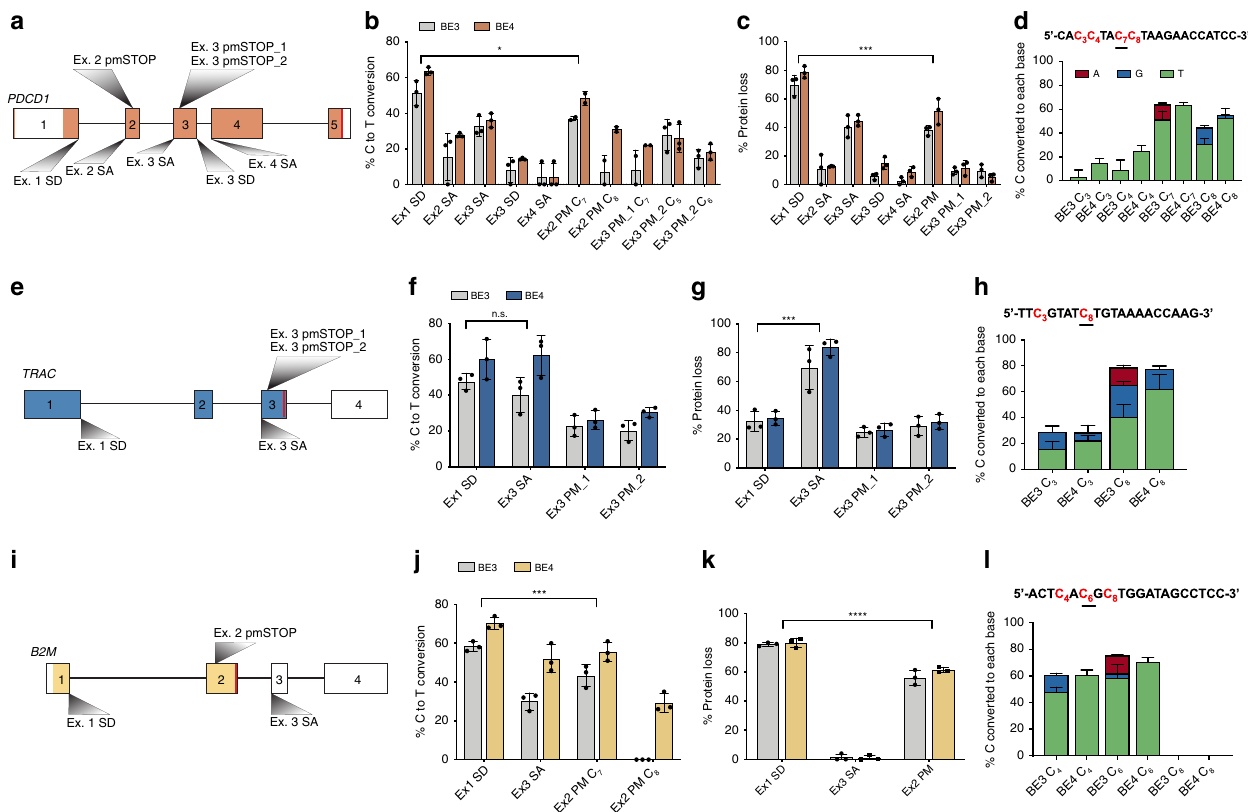
Fig. 1 Assessment of guide RNA activity for gene disruption at PDCD1 , TRAC, and B2M . a Diagram of PDCD1 locus indicating the relative locations of each sgRNA. Colored portion of boxes represent protein-coding region, vertical red line indicates stop codon. b Quanti fi cation of C to T conversion of target base for each PDCD1 sgRNA ( n = 3 independent T-cell donors). c PDCD1 protein knockout frequency ( n = 3 independent T-cell donors). d Quanti fi cation of C to T/A/G conversion at all Cs within the detected editing window (shown in red) of the PDCD1 Ex1 SD sgRNA (n = 3 independent T-cell donors). Underlined C indicates target nucleotide critical for proper splicing. e Diagram of TRAC locus indicating the relative locations of each sgRNA. f Quanti fi cation of C to T conversion at target base for each TRAC sgRNA ( n = 3 independent T-cell donors). g TRAC protein knockout frequency as determined by fl ow cytometry for CD3 loss ( n = 3 independent T-cell donors). h Quanti fi cation of C to T/A/G conversion at all cytosines within the detected editing window (shown in red) of the TRAC Ex3 SA sgRNA ( n = 3 independent T-cell donors). i Diagram of B2M locus indicating the relative locations of each sgRNA. j Quanti fi